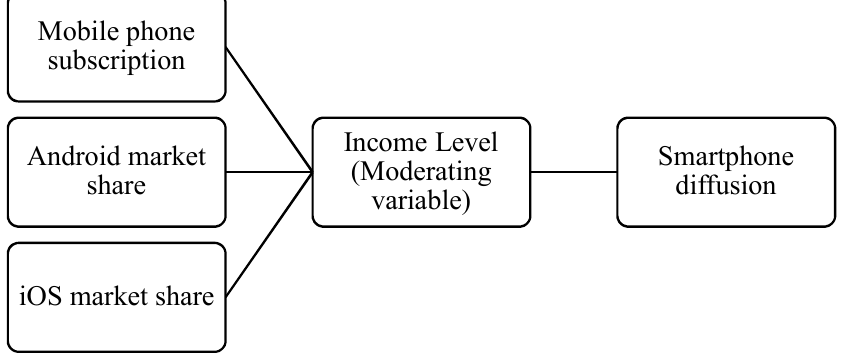
Fig. 2. Research model